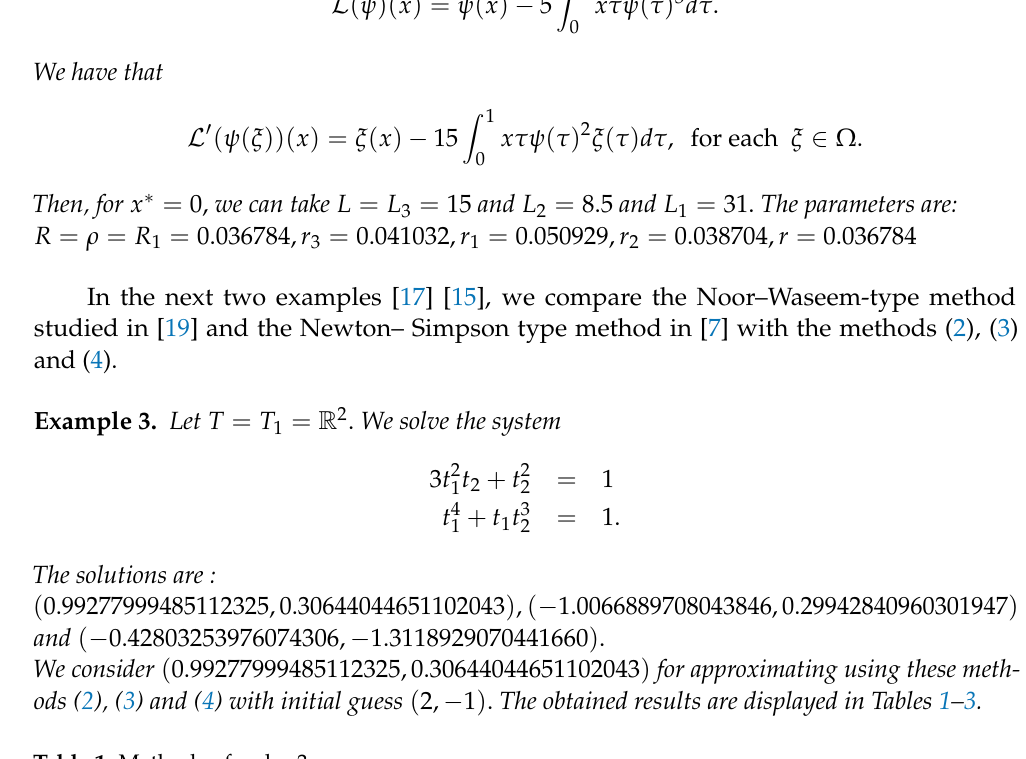
Table 1. Methods of order 3.